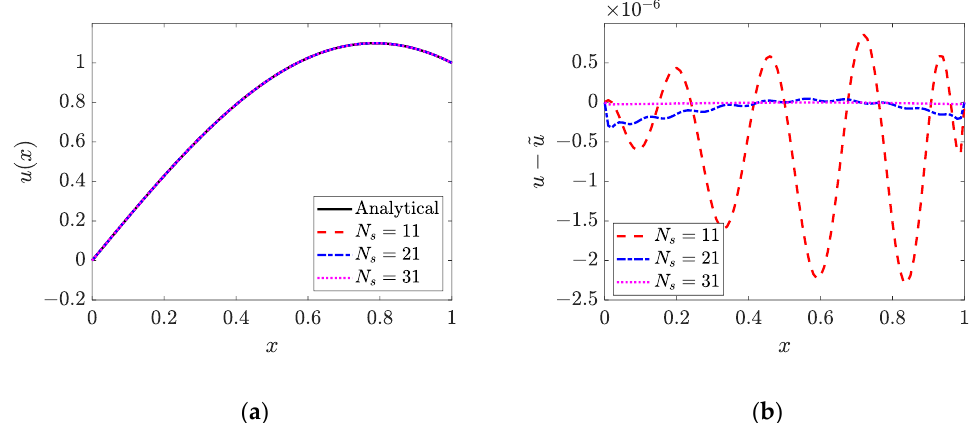
Figure 1. Variation of accuracy and condition number of the stiffness matrix with shape parameter